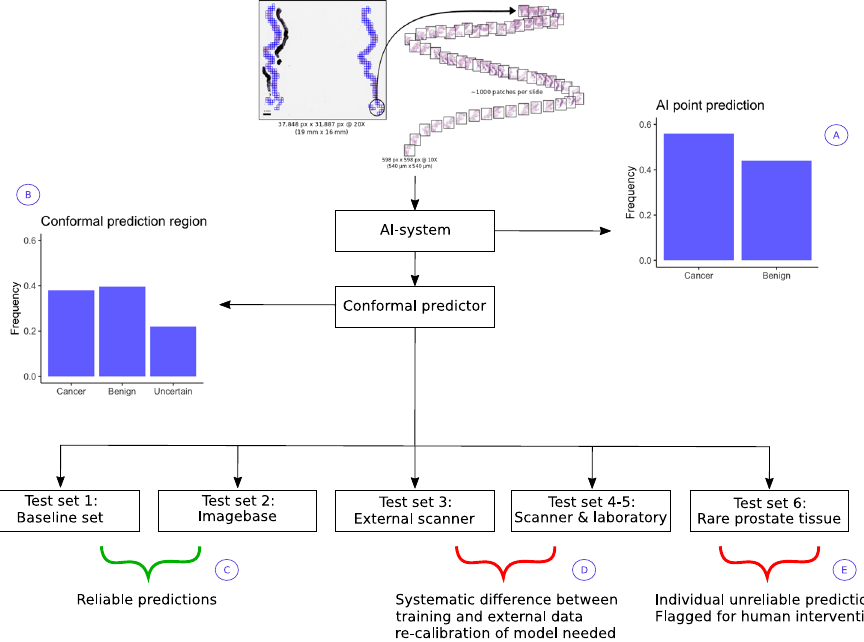
Fig. 1|Overview ofstudydesign.A TheAIsystemdeliverspointpredictions,with no assessment of how reliable they are. B Conformal prediction is used to identify unreliable predictions from AI models. Unreliable predictions from AIsystems can occur for several reasons, for example, because the AI system is presented with atypical data that it has not seen during training or because there are systematic differencesbetween training dataand data generated withinthe setting thatthe AI system is deployed. C Two datasets were utilized for the evaluation of AI cancer detection and ISUP grading performance under idealized conditions, where biop-